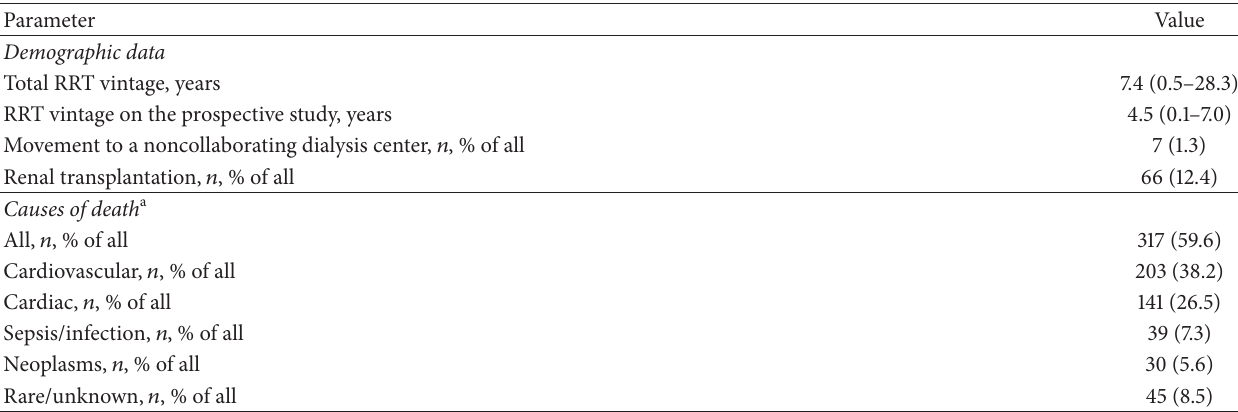
Table 2: Characteristics of hemodialysis patients at the end of a 7-year prospective study.